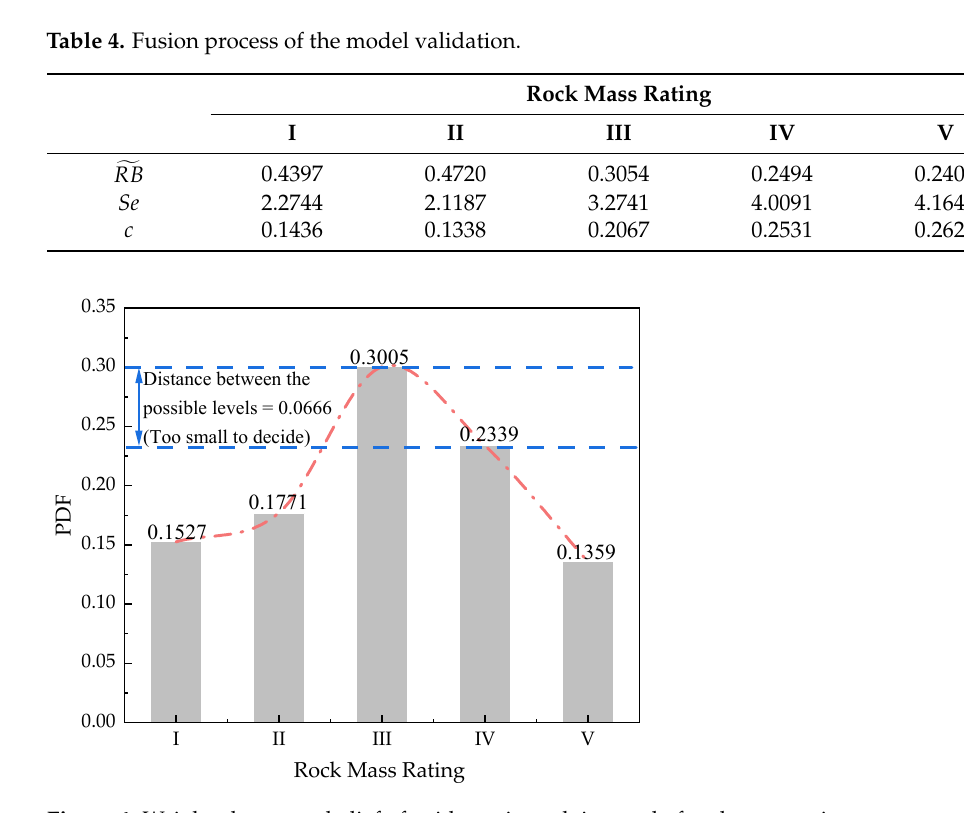
Figure 4. Weighted average belief of evidence in each interval of rock mass rating.